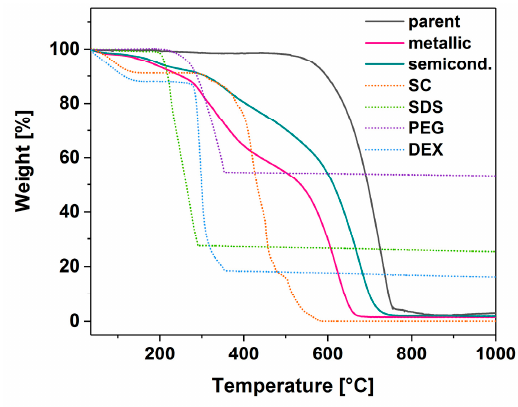
Figure 7. Thermograms of parent and sorted material as well as those of ATPE components.